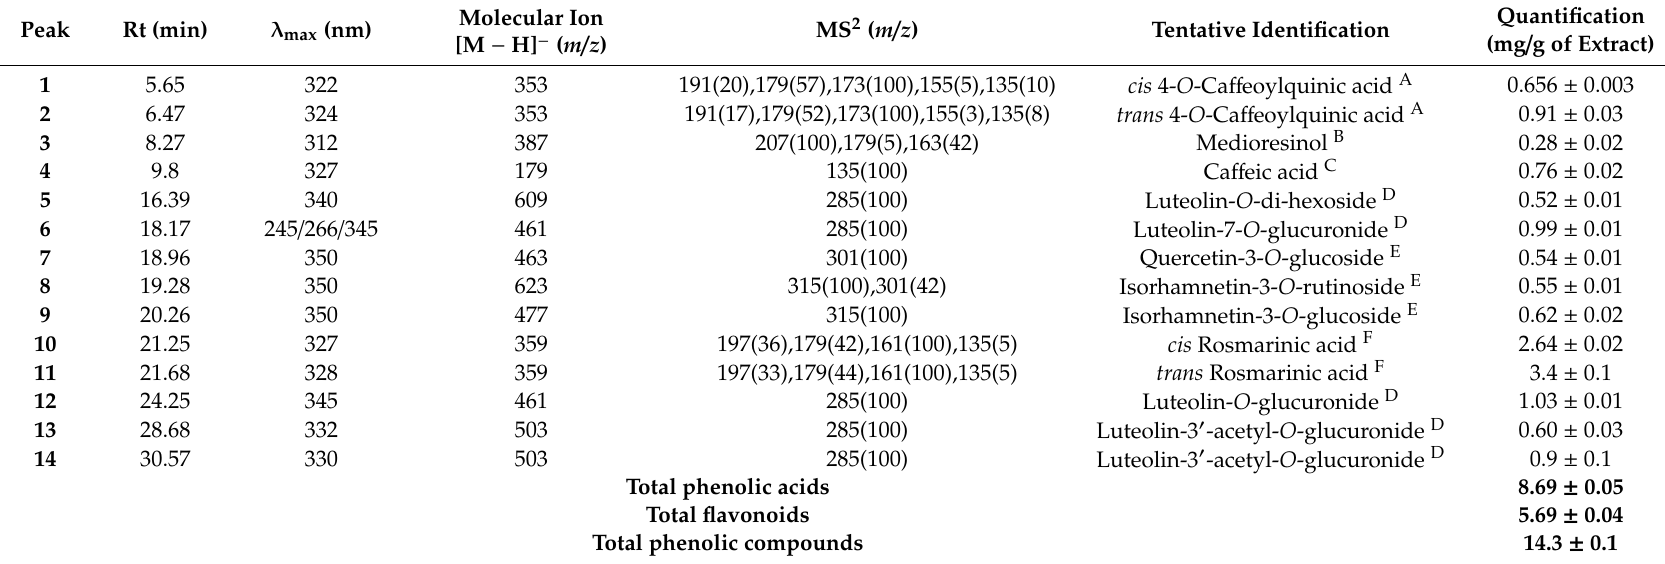
Table 1. Retention time (Rt), wavelengths of maximum absorption in the visible region ( λ max ), mass spectral data, tentative identification and quantification (mg / g of extract) of the phenolic compounds present in Rosmarinus o ffi cinalis L.